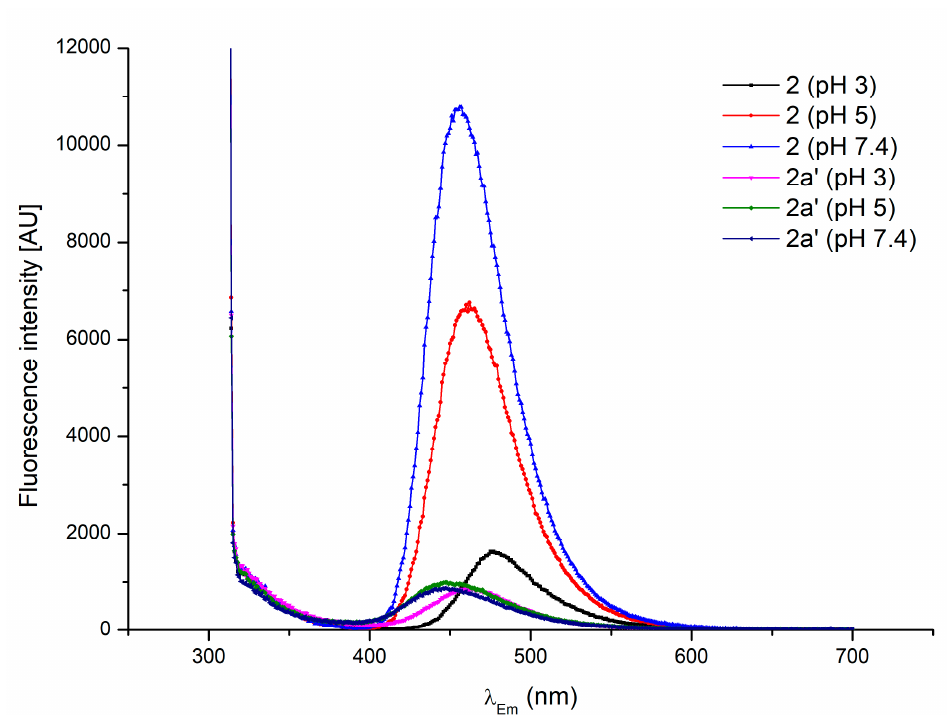
Figure 7. Steady-state fluorescence spectra of the isolated derivative 2a ′ and its respective substrate 2 recorded at conditions identical to those applied for the hypochlorite sensing experiment (concentration of 150 μ M, various pH levels, λ Ex 289, temperature of 25 °C).